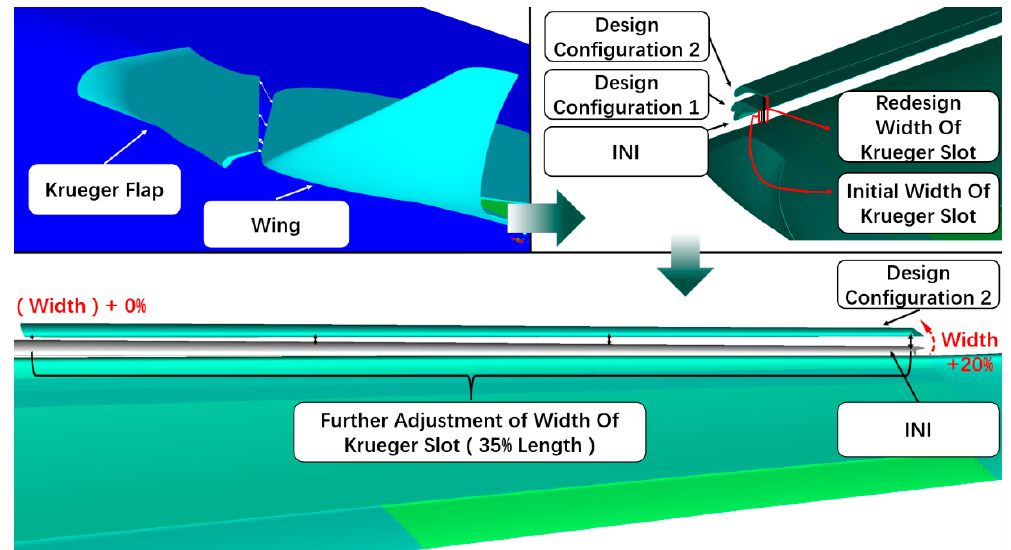
Figure 23. Redesign of the width of the outboard Krueger flap slot.